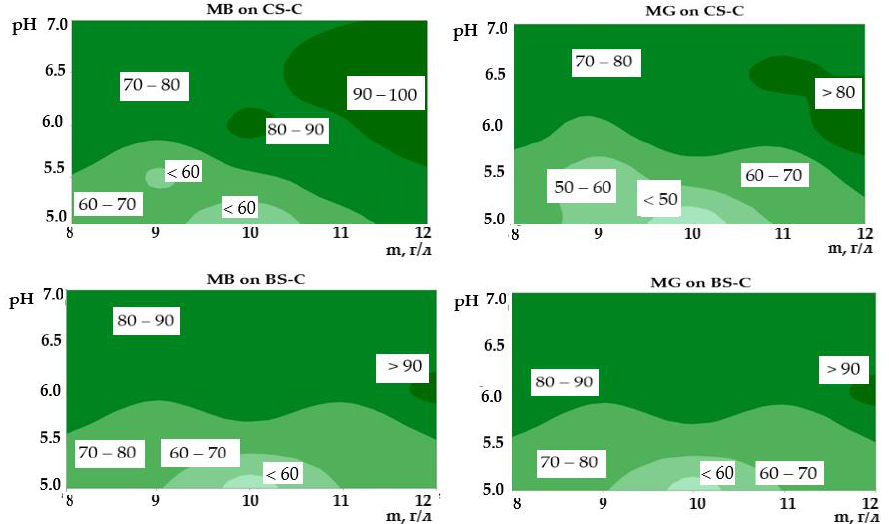
Figure 2. Contour plots showing the effects of pH and adsorption dose on efficiency removal (the corresponding numbers in % were superimposed on the colors) of the cationic dyes (values of other factors in their center point).